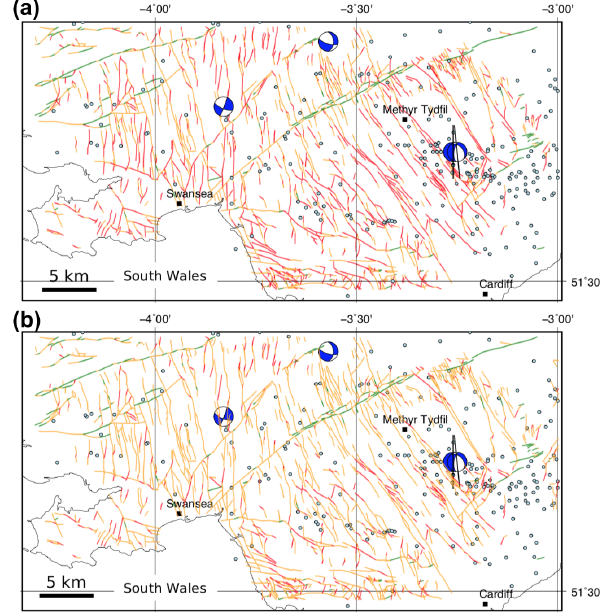
Figure 17. Output from the Monte Carlo modelling of slip tendency ( T s ) in South Wales coalfield. (a) Colour-coded fault map show- ing conditional probability of slip for each mapped fault. This map shows the unweighted values, as shown on the CDFs in Fig. 14a. (b) Colour-coded fault map showing conditional weighted proba- bility of slip for each mapped fault. The weighted probability is calculated by multiplying the probability from the CDF in Fig. 14a by the normalized fault smoothness, ranging from 1.0 for a per- fectly straight (i.e. smooth) fault and tending to 0.0 for a rough fault. Colour coding of CDFs is as follows: red shows > 33% chance of exceeding threshold friction ( µ = 0 . 3), amber shows between > 1% and < 33% chance, and green shows < 1%